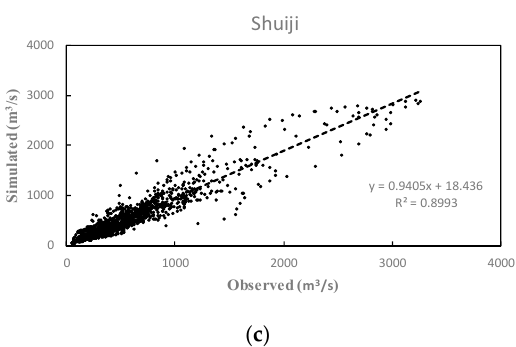
Figure 6. The fitting lines between measured and calculated runoff value in validation stage via the method of least square. ( a ), ( b ), ( c ) are for Jiangyang basin, Shaowu basin and Shuiji basin respectively. Table 4. Summarized values of evaluation criteria and performance of 10 calibrated and 6 validated flood events in Shaowu, Jianyang, and Shuiji watershed.